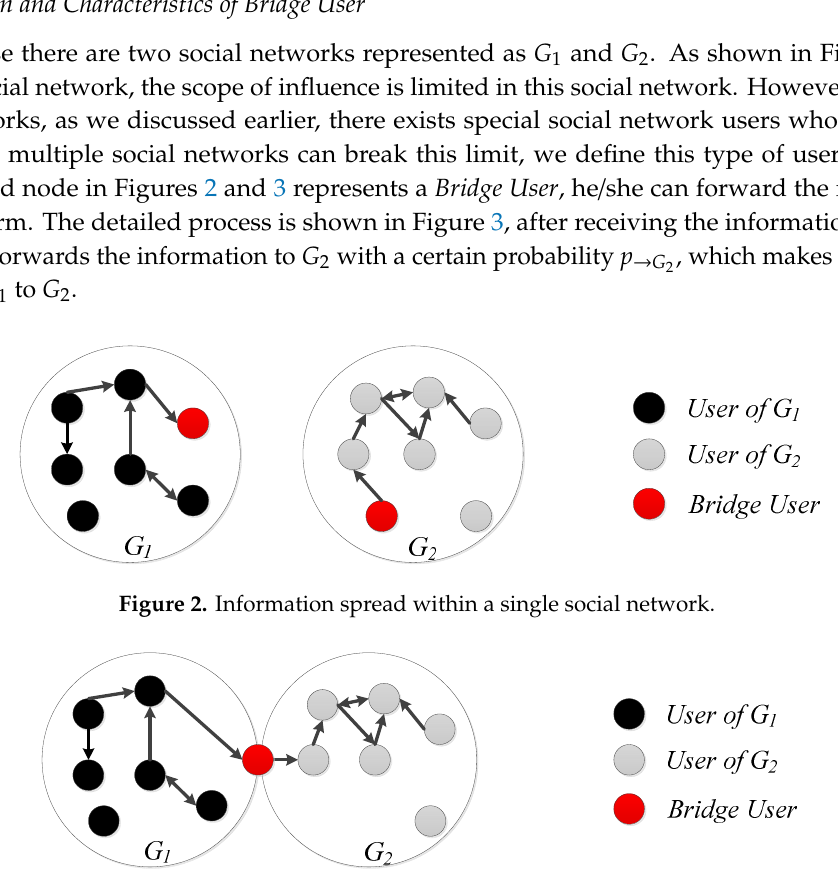
Figure 3. Bridge User forwards the information from G 1 to G 2